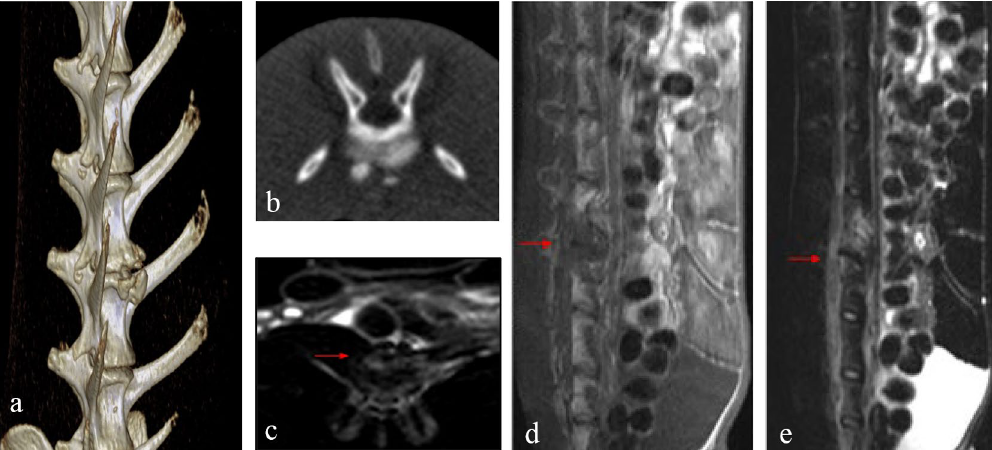
Figure 2. A New Zealand rabbit model of spinal tuberculosis (imaging data): ( a ) CT reconstruction showed narrowing of the intervertebral disc space, destruction of adjacent vertebral bodies, marginal and worm-like destruction of the affected vertebral body; ( b ) CT scan showed vertebral bone destruction; ( c ) Swelling of the psoas major muscle and paravertebral abscess; ( d – e) Long low-intensity signals on T1WI and mixed high- intensity signals on T2WI in the sagittal view.